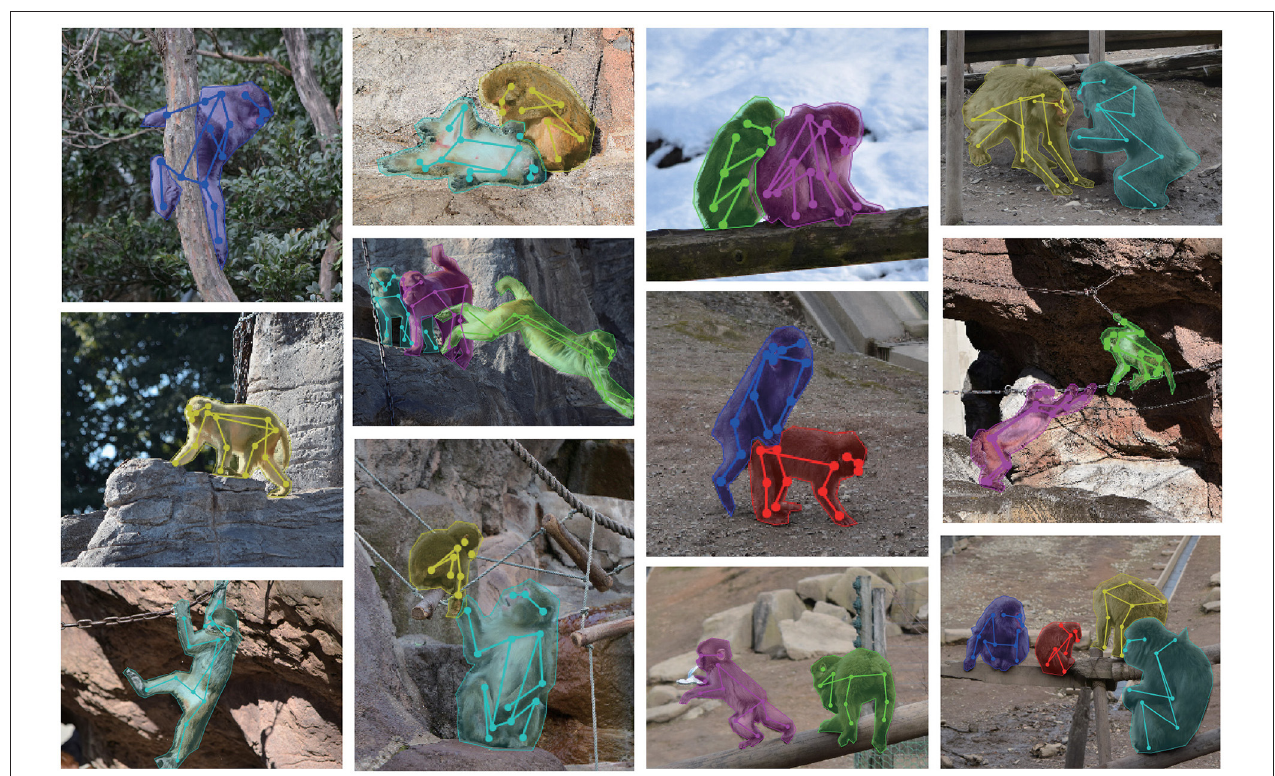
FIGURE 1 | Examples of pictures and labels in the present